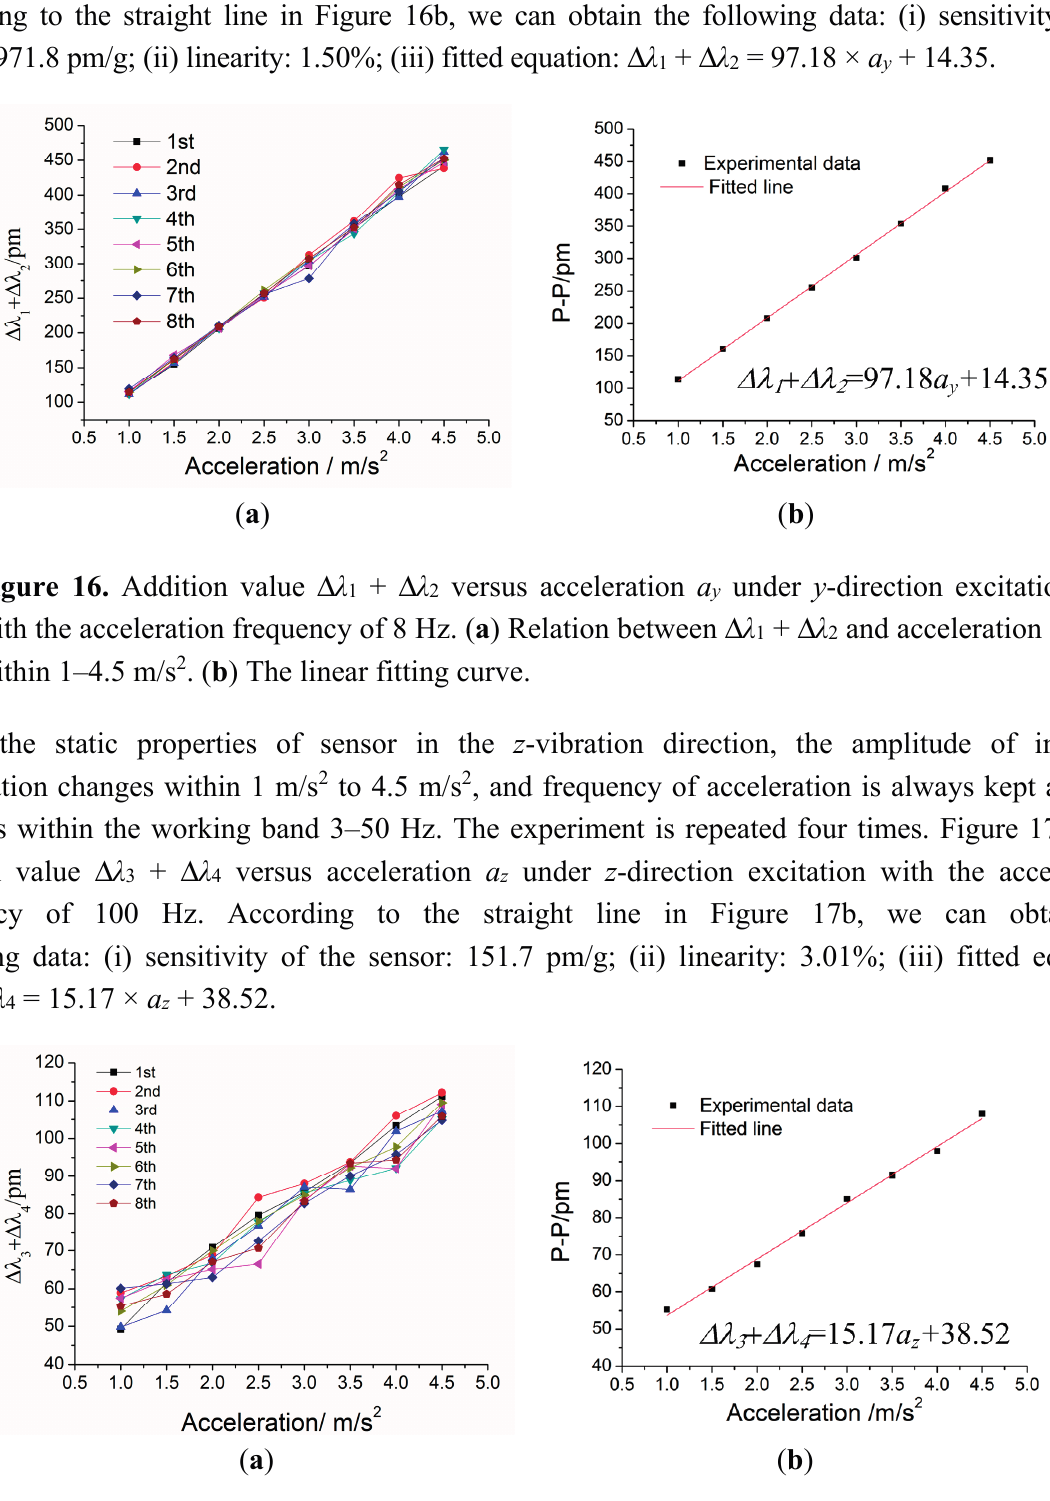
Figure 17. Addition value Δ λ 3 + Δ λ 4 versus acceleration a z under z -direction excitation with the acceleration frequency of 8 Hz. ( a ) Relation between Δ λ 3 + Δ λ 4 and acceleration a z within 1–4.5 m/s 2 . ( b ) The linear fitting